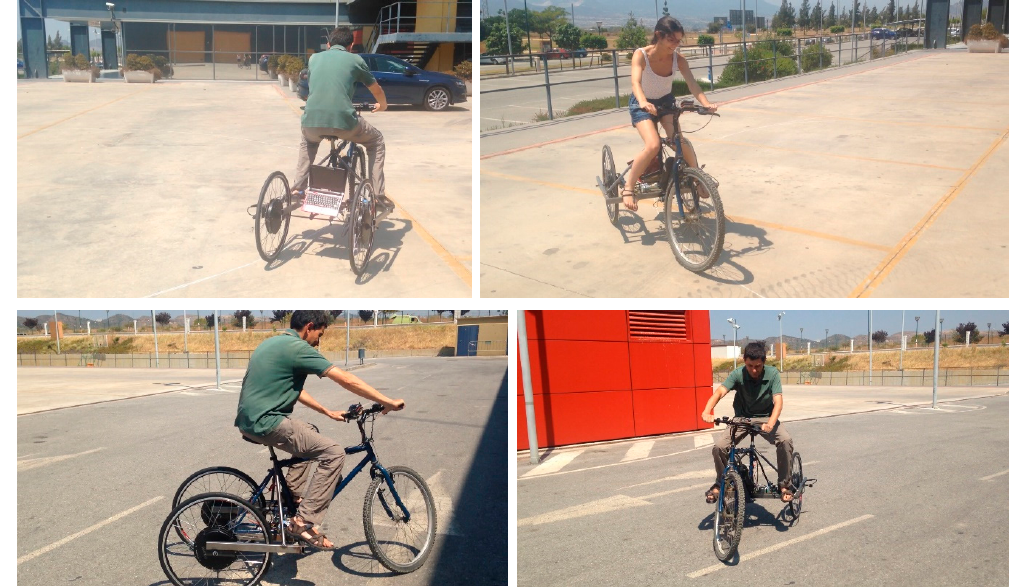
Figure 6. circuits designed and used: Top: circular path. Bottom: Slalom path. Figure 6. Circuits designed and used: Top: circular path. Bottom: Slalom path.